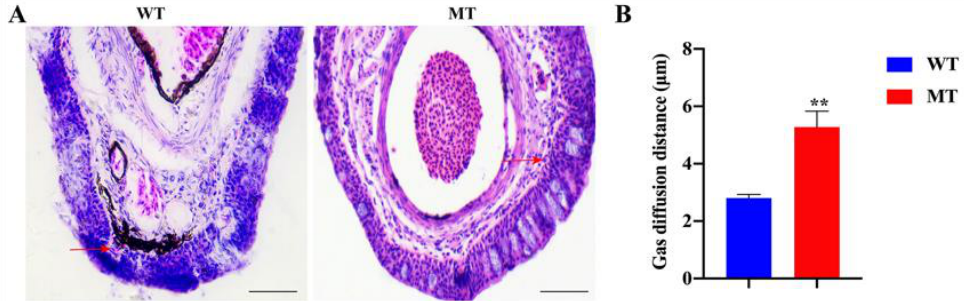
Figure 7. Histological structures ( A ) and gas diffusion distances ( B ) of barbels in WT and MT loach. Red arrows show capillaries. WT, wild-type loach; MT, fn1b- depletion loach. Scale bar = 100 μm. ** very significant difference ( p < 0.01).